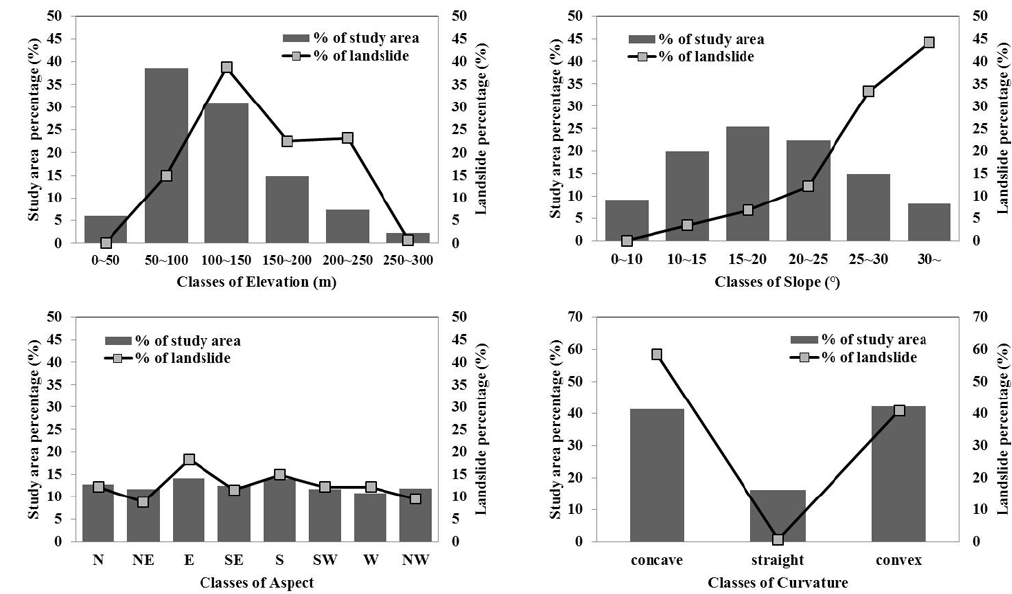
Fig. 11. Factor of safety (FS) at different times in the study